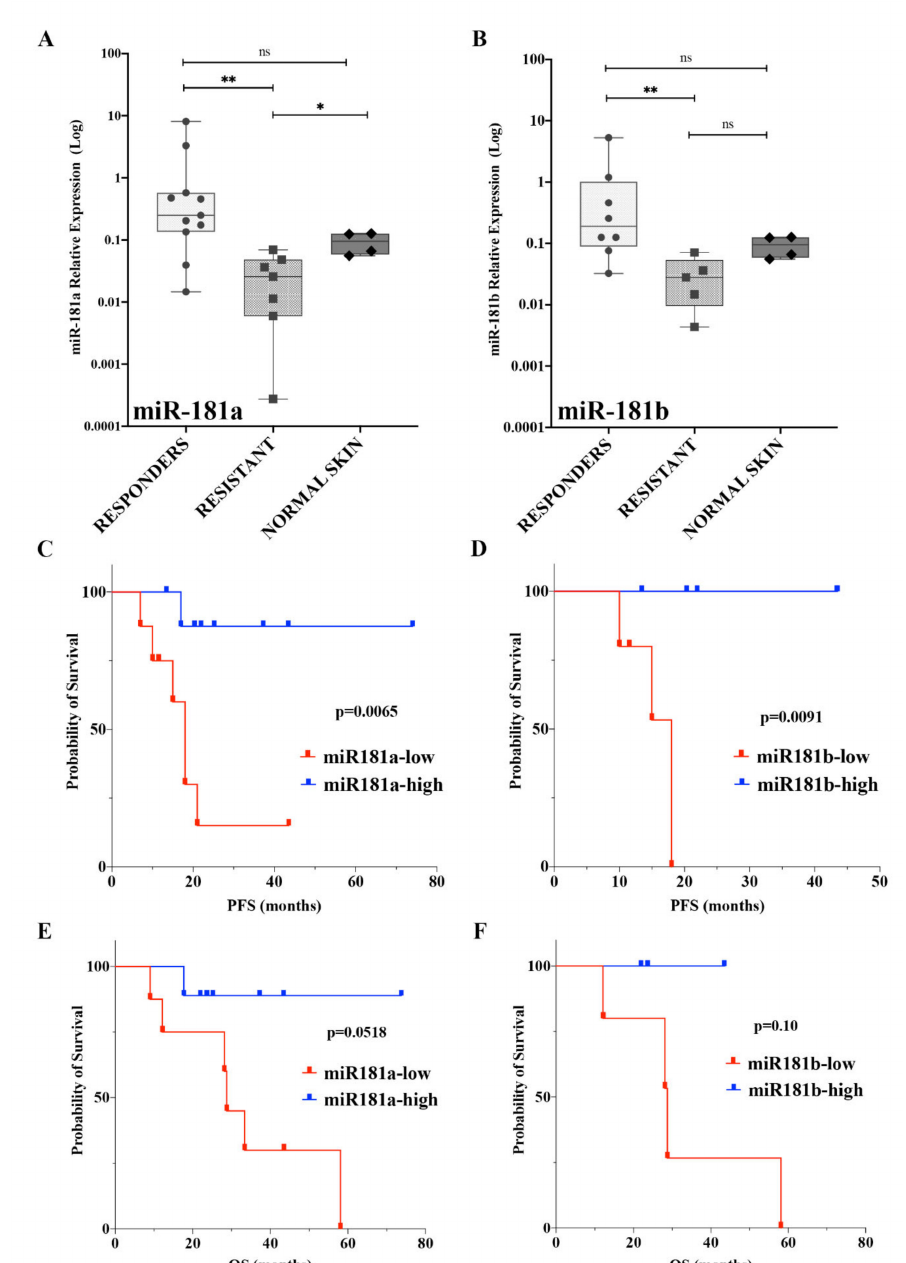
Figure 4. ( A , B ) Box-and-whisker diagrams of miRNA-181a ( A ) and -181b ( B ) levels in melanoma patients grouped according to best response to the treatment and in normal skin sample. The horizontal bar within each box indicates the median. Data were analysed by non-parametric Wilcoxon matched-pairs signed-rank test. ** p < 0.001; * p < 0.01; ns = not significant. ( C,D ) Relationship between the expression of miRNA-181a ( C ) and -181b ( D ) in melanoma tissues and the prognosis of patients. The PFS (progression free survival) rate of the high miRNA-181a ( B ) and -181b ( C ) expression group was higher than that of the low microRNAsexpression group ( p = 0.0065; p = 0.0091). ( E,F ) Kaplan-Meier Log-rank survival analysis for overall survival (OS) of melanoma patients according to miR-181a ( E ) and -181b ( F) expression ( p = 0.0518; p =